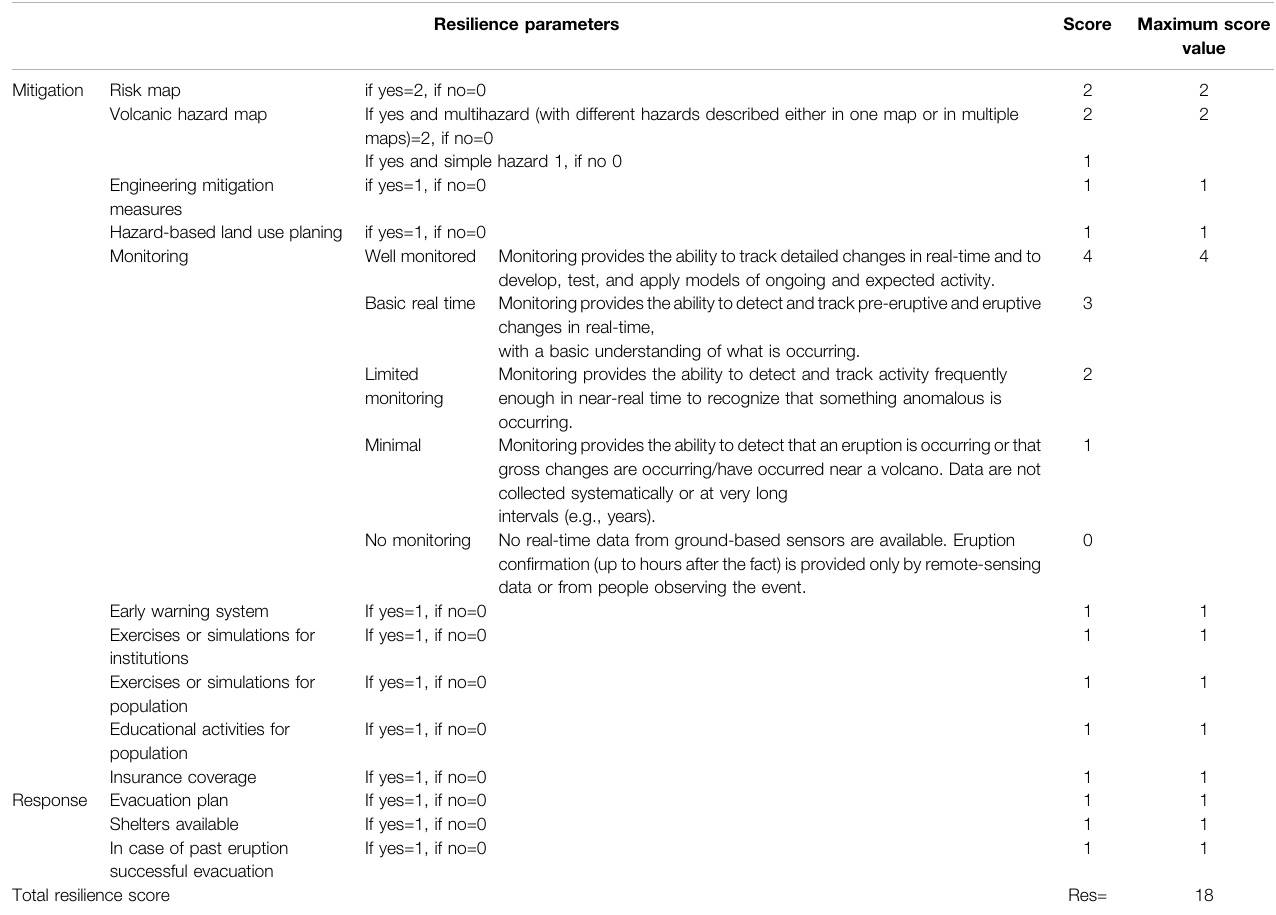
TABLE 4 | Resilience parameters evaluated in the new ranking strategy. Monitoring parameters are adapted from Ewert et al. (2005). Resilience